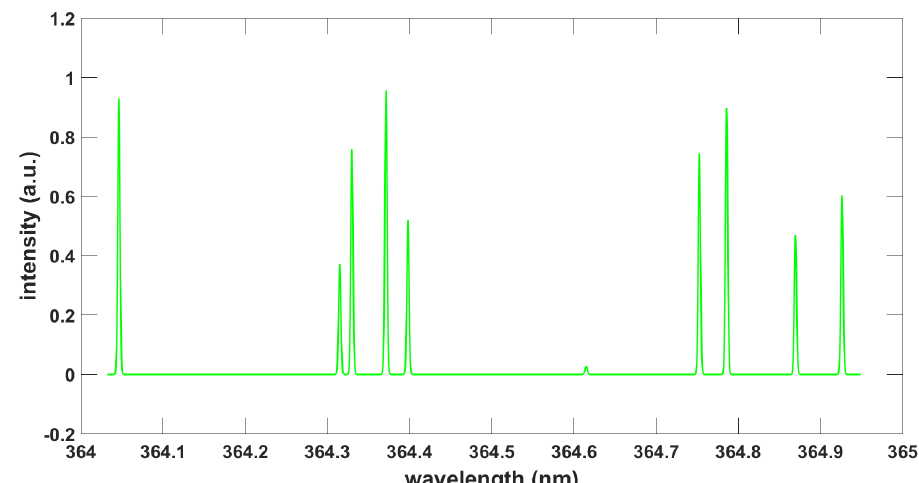
Figure 6. Computed CH B − X emission spectrum, δ λ = 0.0033nm, T = 0.65